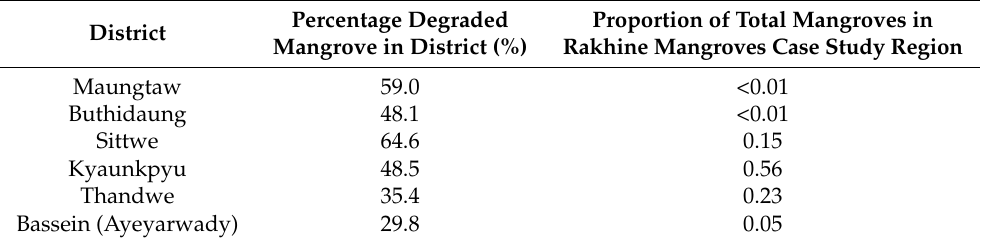
Table 3. Percentage of mangroves mapped as degraded per district sorted by latitude and the per- centage of mangroves within each district relative to the entire Rakhine mangroves case study region. Percentage Degraded Proportion of Total Mangroves in District Mangrove in District (%) Rakhine Mangroves Case Study Region Maungtaw 59.0 <0.01 Buthidaung 48.1 <0.01 Sittwe 64.6 0.15 Kyaunkpyu 48.5 0.56 Thandwe 35.4 0.23 Bassein (Ayeyarwady) 29.8 0.05